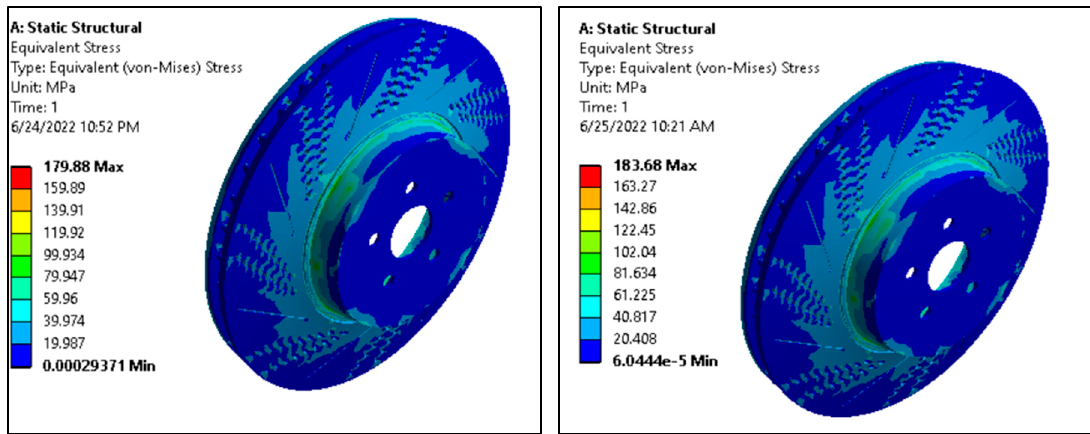
Figure 4. Von Mises stress of aluminum alloy vs. AMNCs ventilated disc.